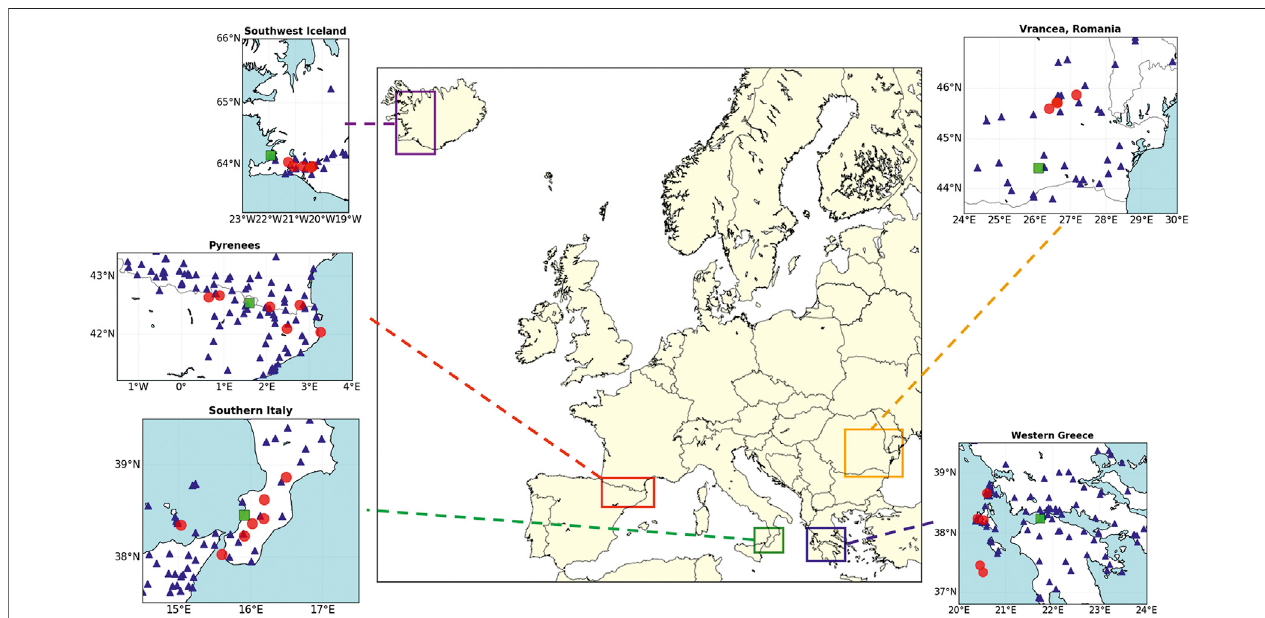
FIGURE 2 | Locations of the earthquakes (red circles) and target sites (green squares) considered in this study. Blue triangles represent the considered seismic stations. The target sites are the Port of Gioia Tauro for Southern Italy, Andorra for the Pyrenees, Reykjavík for Southwest Iceland, Patras for Western Greece and Bucharest for